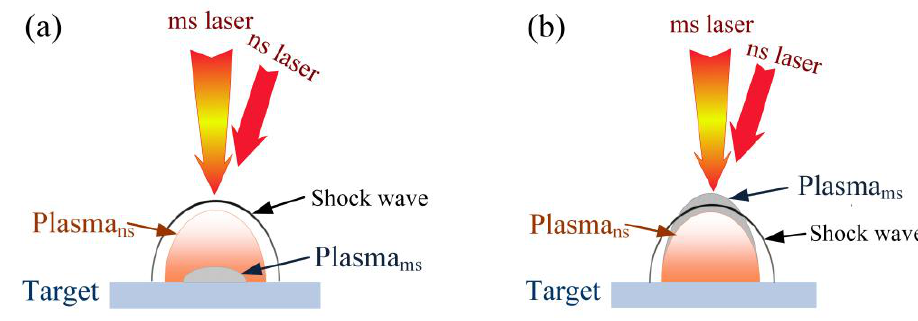
Figure 8. The schematic diagram of shock wave acceleration mechanism ( a ) in case 1 and ( b ) in case